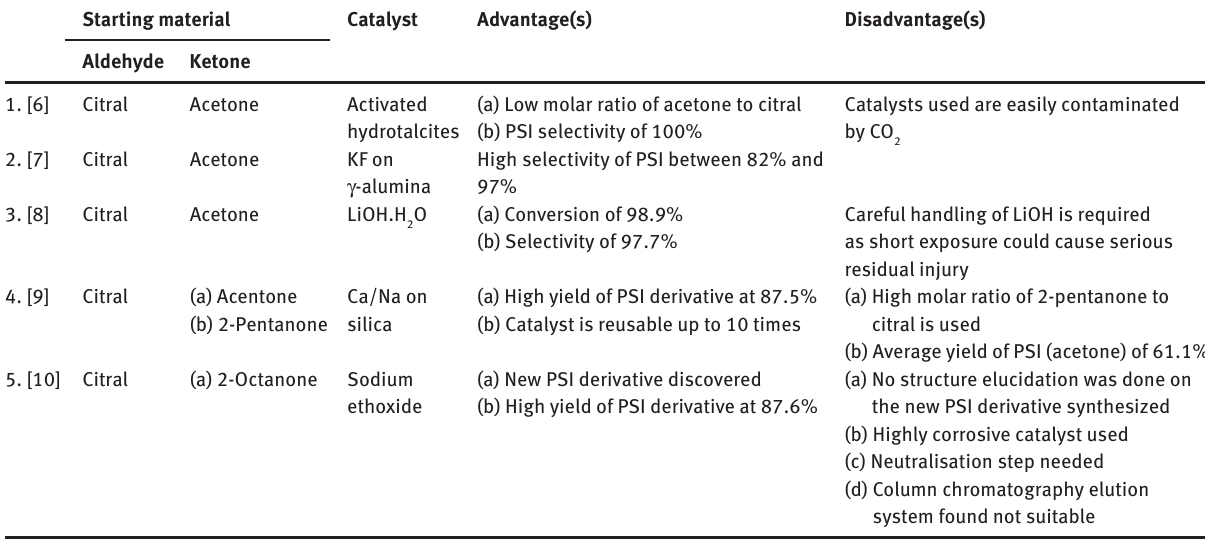
Table 1: Recent development in the synthesis of pseudoionone (PSI) derivatives. Starting